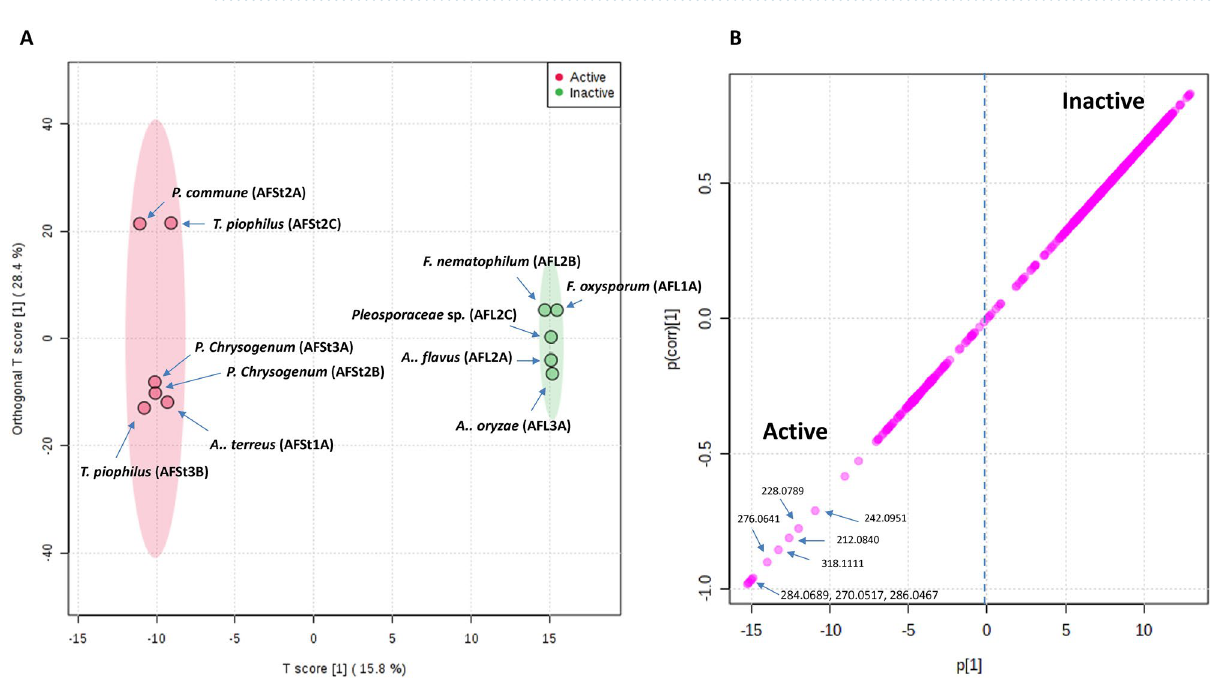
Figure 4. OPLS-DA score plot ( A ) along with its S-plot illustrating the masses of the most important metabolites ( 1–8 ) that may be associated with the anti-plasmodial activity ( B ). The plots were generated by MetaboAnalyst 4.0 28 (https ://www.metab oanal yst.ca/Metab oAnal yst/Modul eView .xhtml